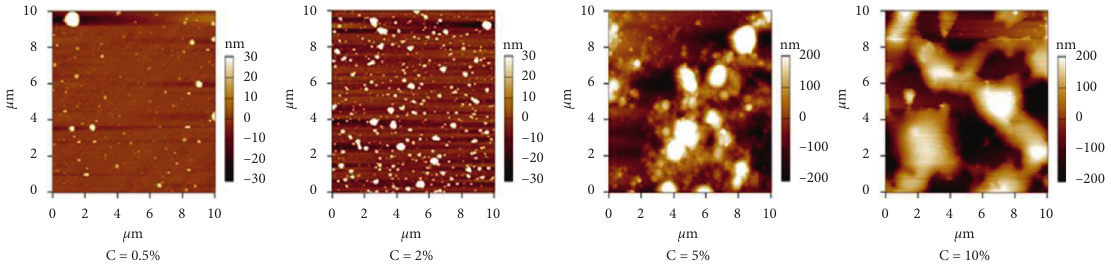
Figure 8: Stripping effect of heavy oil with different concentrations of